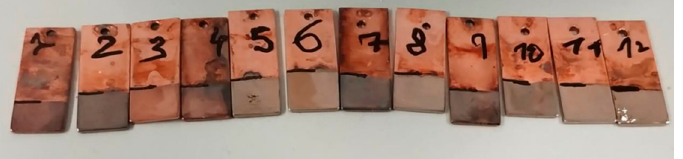
Figure 1. Aesthetic appearance of palladium films obtained by displacement plating. Sample numbers are reported on the uncoated part of each sample.